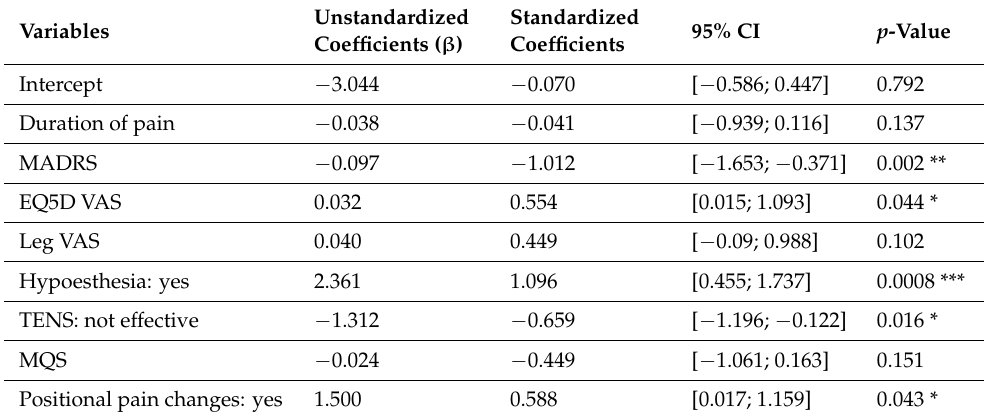
Table 5. Standardized coefficients of selected variables, confidence intervals and significance